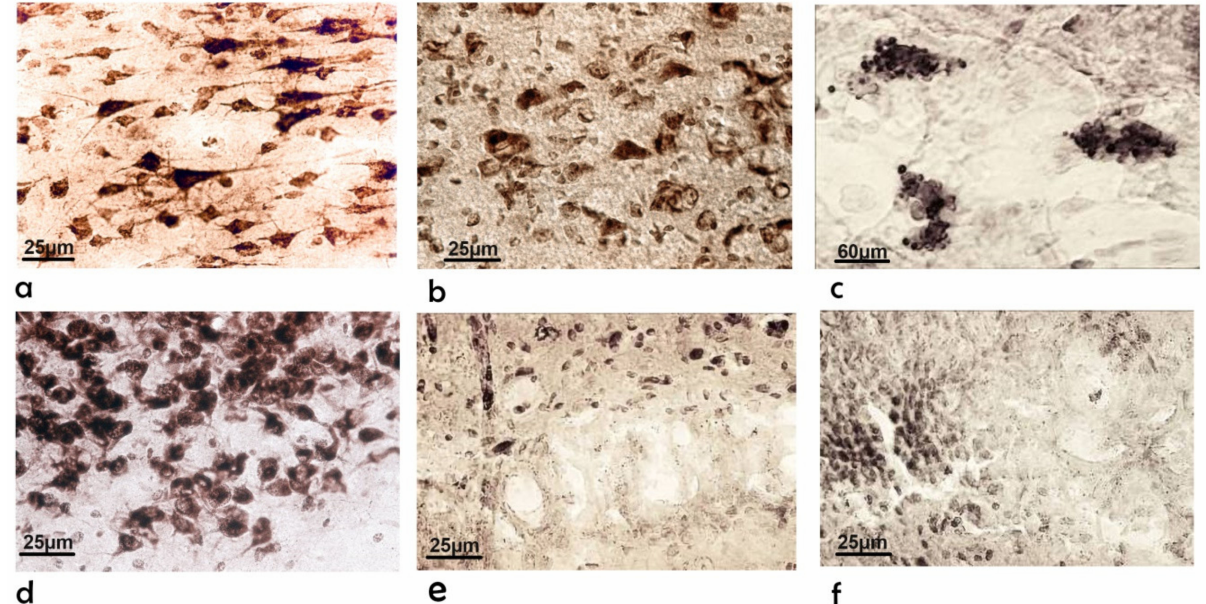
Figure 5. Microphotographs of rats’ brain sections: ( a – c ) cerebral cortex, ( d – f ) hippocampus, ( a , d ) of intact animals; ( b , c , e , f ) animals under the influence of bilateral single i.c.v. administration of A β (1-42). Magnification: 400 × ( a , b , d – f ); 160 × ( c